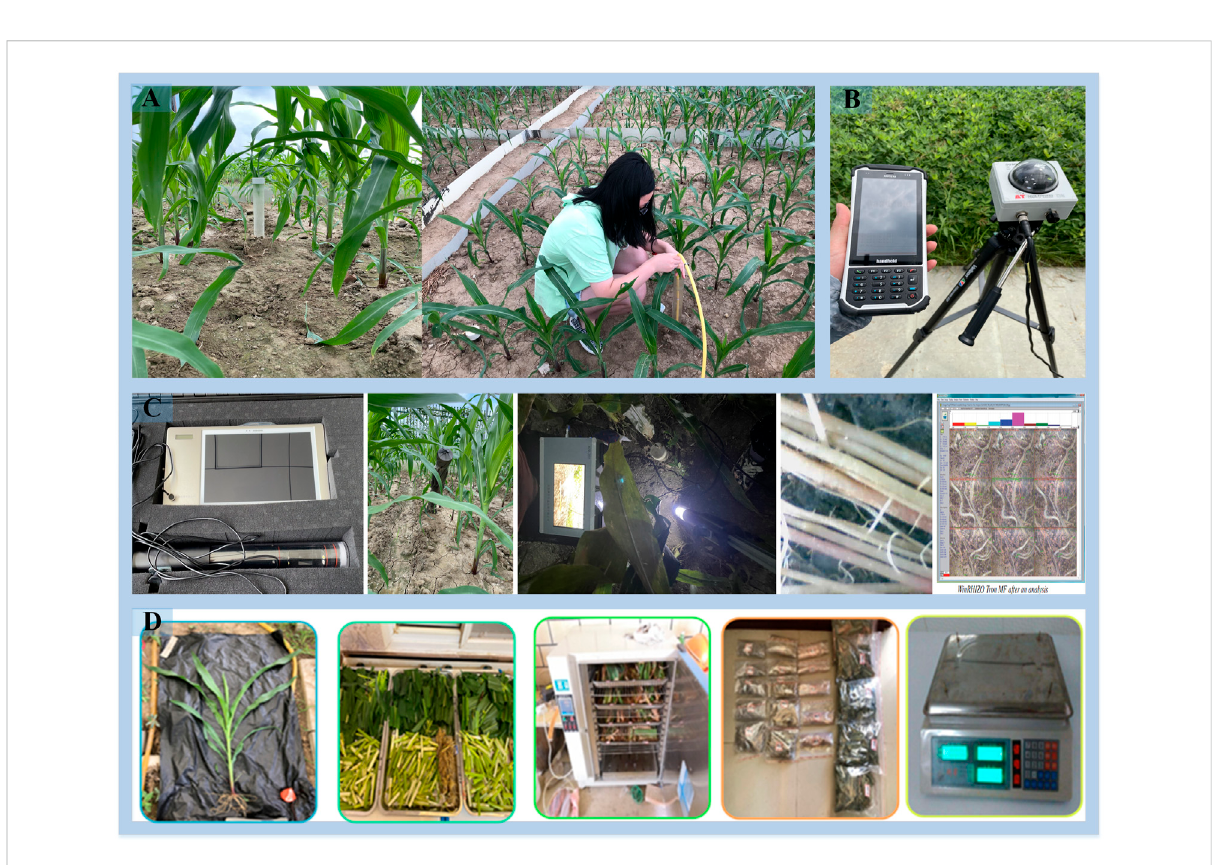
FIGURE 2 Experimentalmonitoringdiagramofsummermaizedeterminationproject. (A) isthemonitoring andmeasurementphoto ofsoilwatercontent, (B) is the measurement instrument of leaf area index, (C) is the monitoring and measurement diagram of summer maize root system, and (D) is the sampling procedure diagram of summer maize